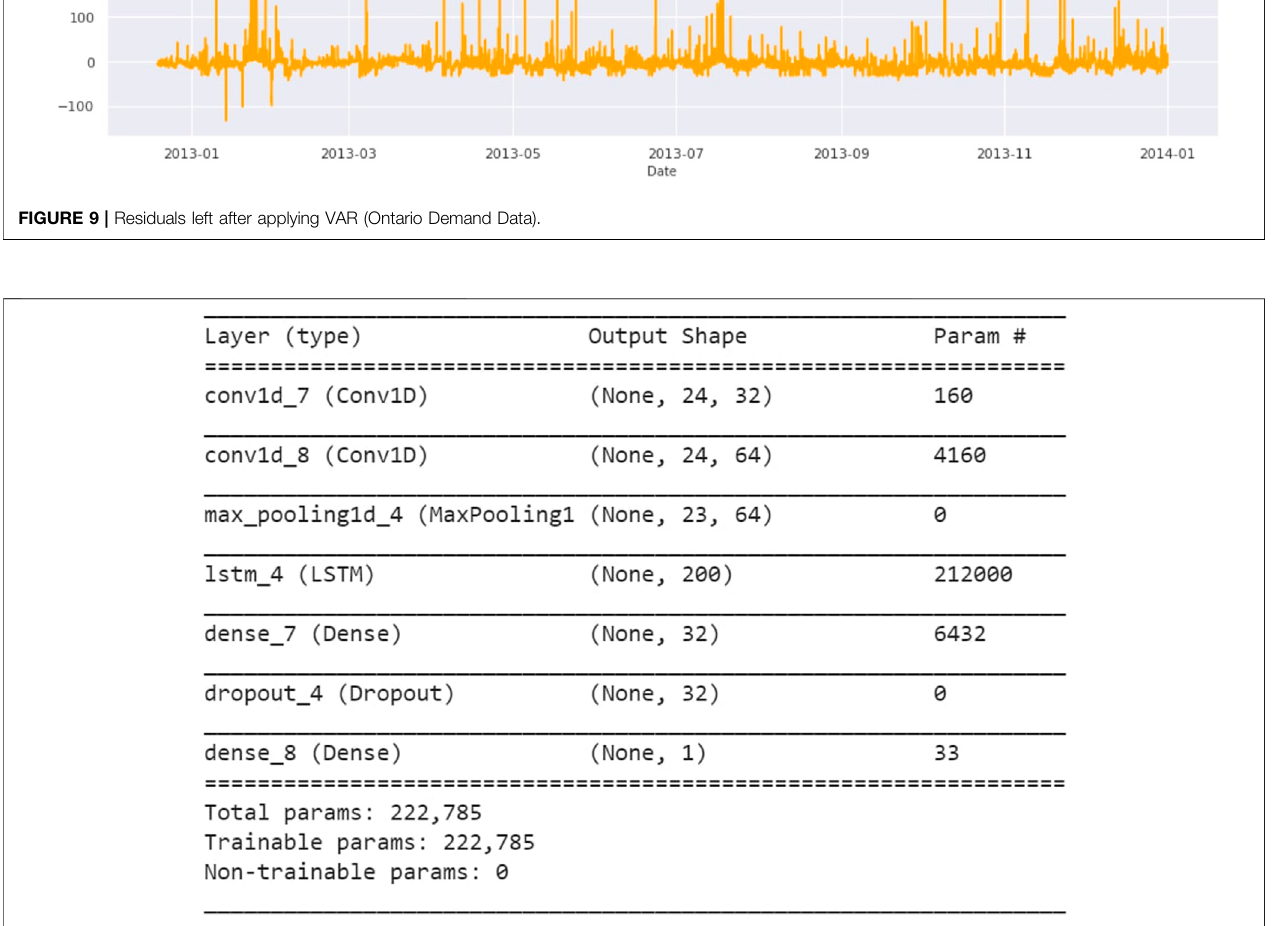
FIGURE 10 | VAR CNN-LSTM model summary (Ontario Demand